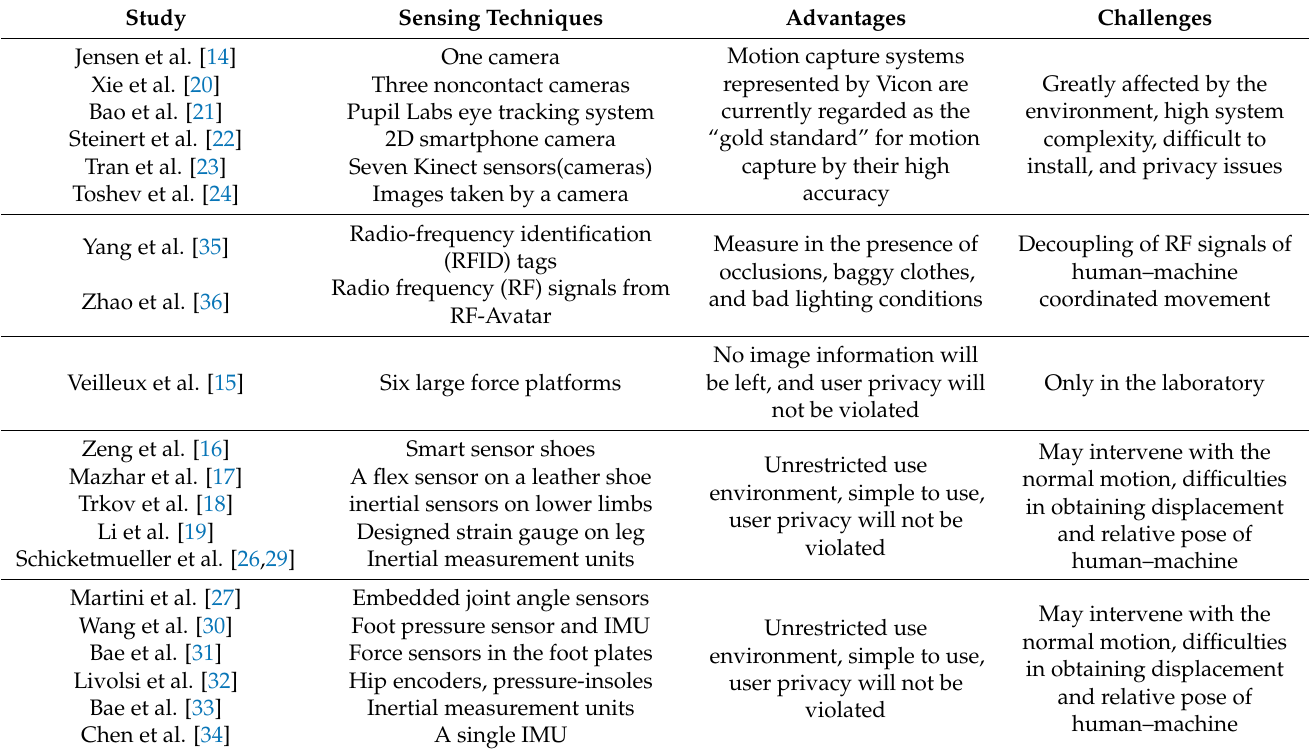
Figure 1. State-of-the-art motion measurement techniques used in gait training systems. Table 1. Gait motion measurement techniques used in each of the included studies and their char- acteristics.